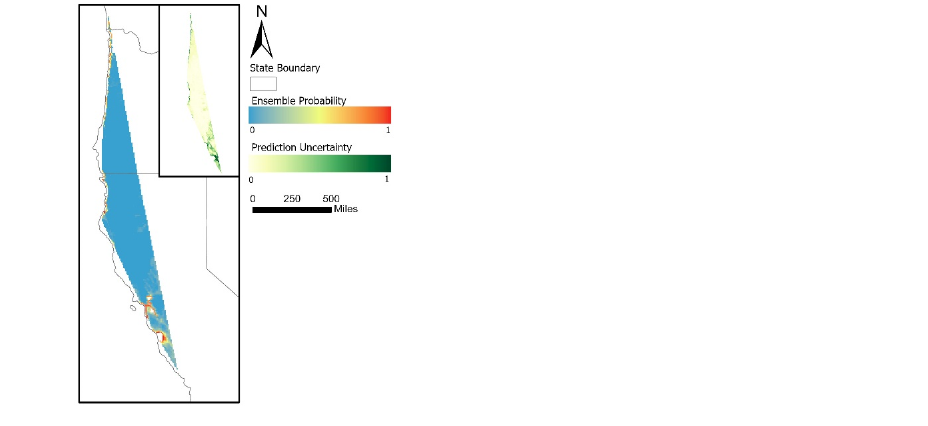
Figure 6. Spatial distributions of the predicted mortality events and the uncertainty in predictions for Common Murre in the western and central United States in 2020.